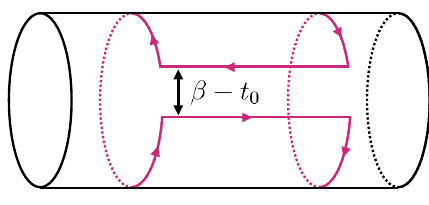
Figure 4. The temporal Wilson loop W µ ( L, t 0 ) considered in this work. A spatial Wilson line with length L is created, goes through Euclidean time evolution around the temporal circle, and is then annihilated. By exchanging the role of time and space, we can interpret this also as the propagation of an open string along the compactified space over Euclidean time L . We will focus on the case of t 0 = β